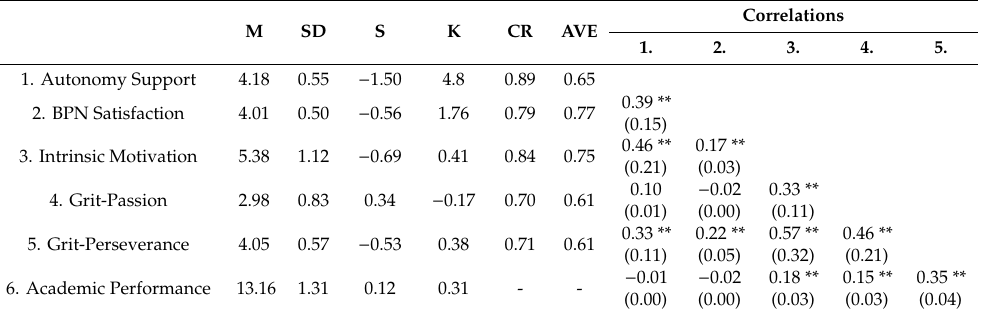
Table 1. Descriptive statistics, Composite Reliability, Average Variance Extracted, and